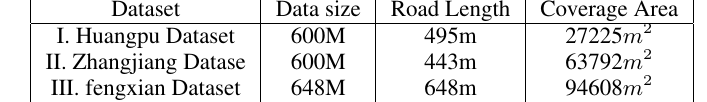
Table 1. Datasets description